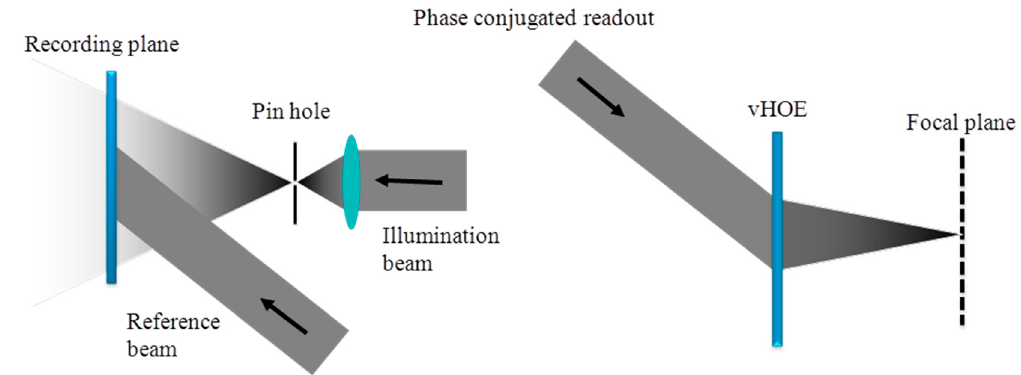
Figure 19. Analog recording scheme for an off axis transmission lens using a pin hole ( left ) as an object. The phase conjugated readout of the off axis transmission lens to reconstruct the real image of the pin hole ( right ) [57].